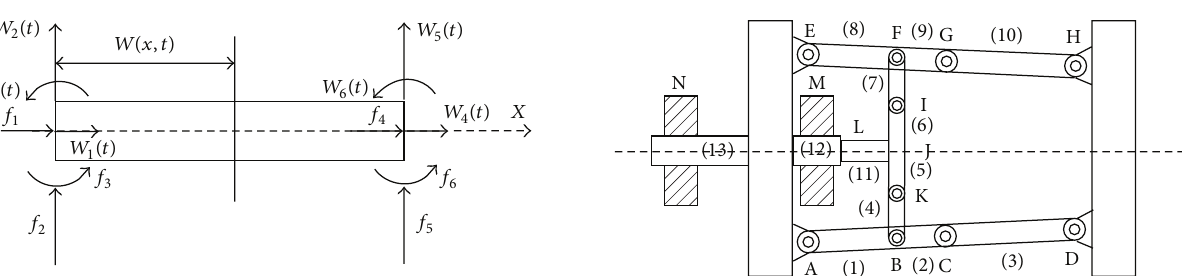
Figure 3: Division of clamping mechanism of beam elements.